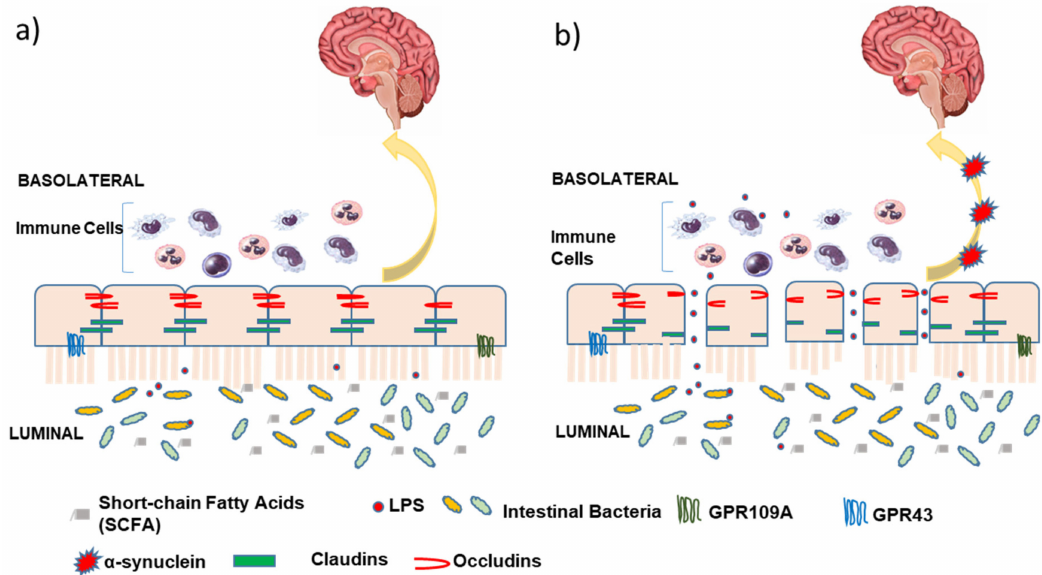
Figure 1. ( a ) Normal intestinal barrier with intact and functional tight junction proteins (Occludins/Claudins); ( b ) Leaky gut with increased intestinal permeability and dysfunctional tight junction proteins. Lipopolysaccharide (LPS) and bacterial toxins result in neuro-inflammation and Lewy pathology in PD